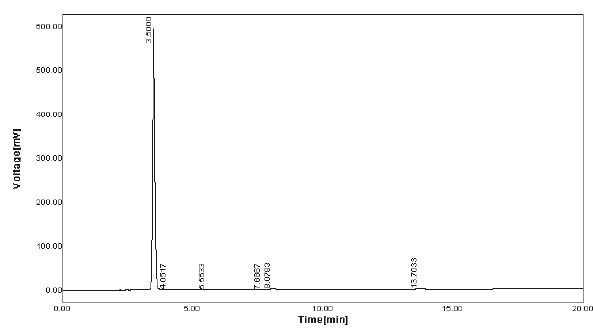
Figure 9: HPLC chromatogram of Standard Pesticide solution.